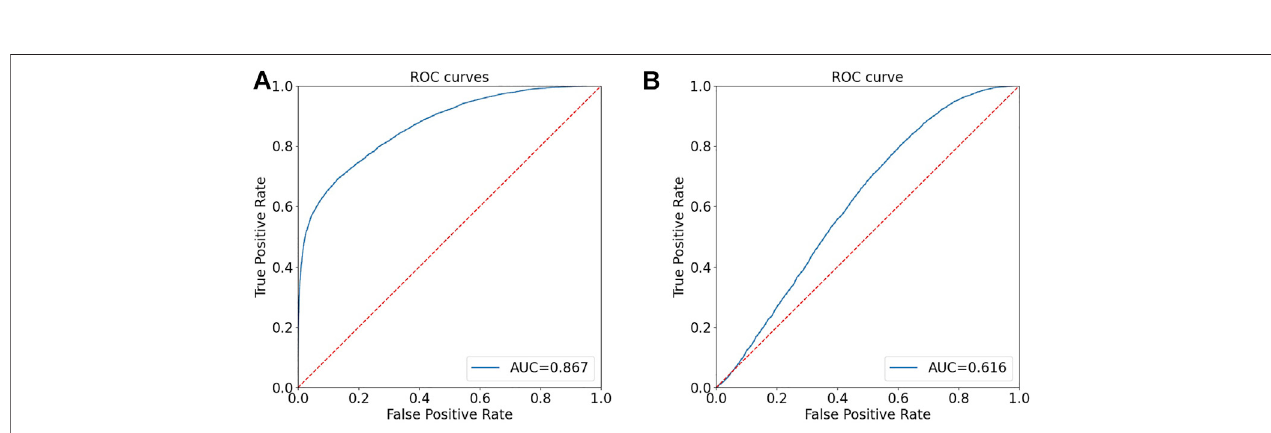
FIGURE6| ExamplesofimagesfromthePrint&Scanimagedataset(Ferreiraetal.,2021)(top),andcorrespondingdigitalimage(bottom).Fromlefttoright,the fi rst 3 images are real, the last 3 are GAN.